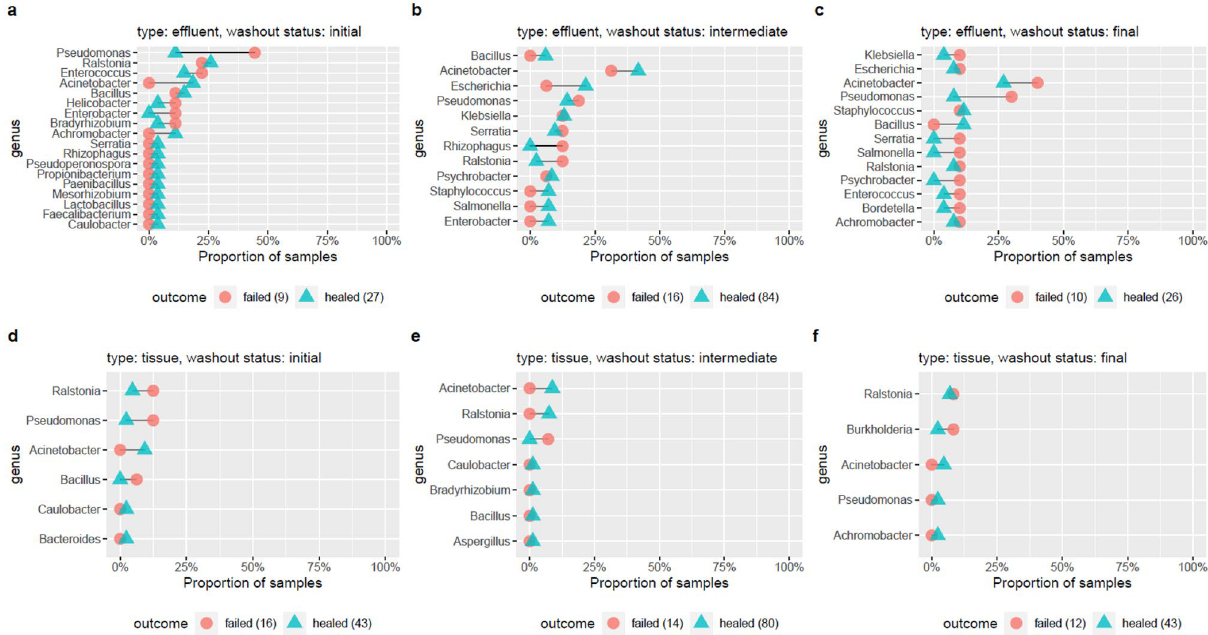
Figure 3. Prevalence of microbial genera in samples derived from healed or failed wounds. Prevalence of detection of microbial genera at defined thresholds was calculated for wounds that either healed successfully or failed to heal. Prevalence is shown as a proportion of total healed or failed samples for each given sample category, where effluent samples are shown in panels ( a-c ), and tissue samples are shown in panels ( d–f) . Samples are shown for initial ( a , d ), intermediate ( b , e ), and final ( c , f ) collection timepoints. Individually significant ( P < 0.05) distinctions are shown with a bolded edge. Depending on time-to-closure for each wound, a variable number of samples were available for intermediate samplings. A total of 100 effluent samples (across 46 wounds) and 94 tissue samples (across 49 wounds) were